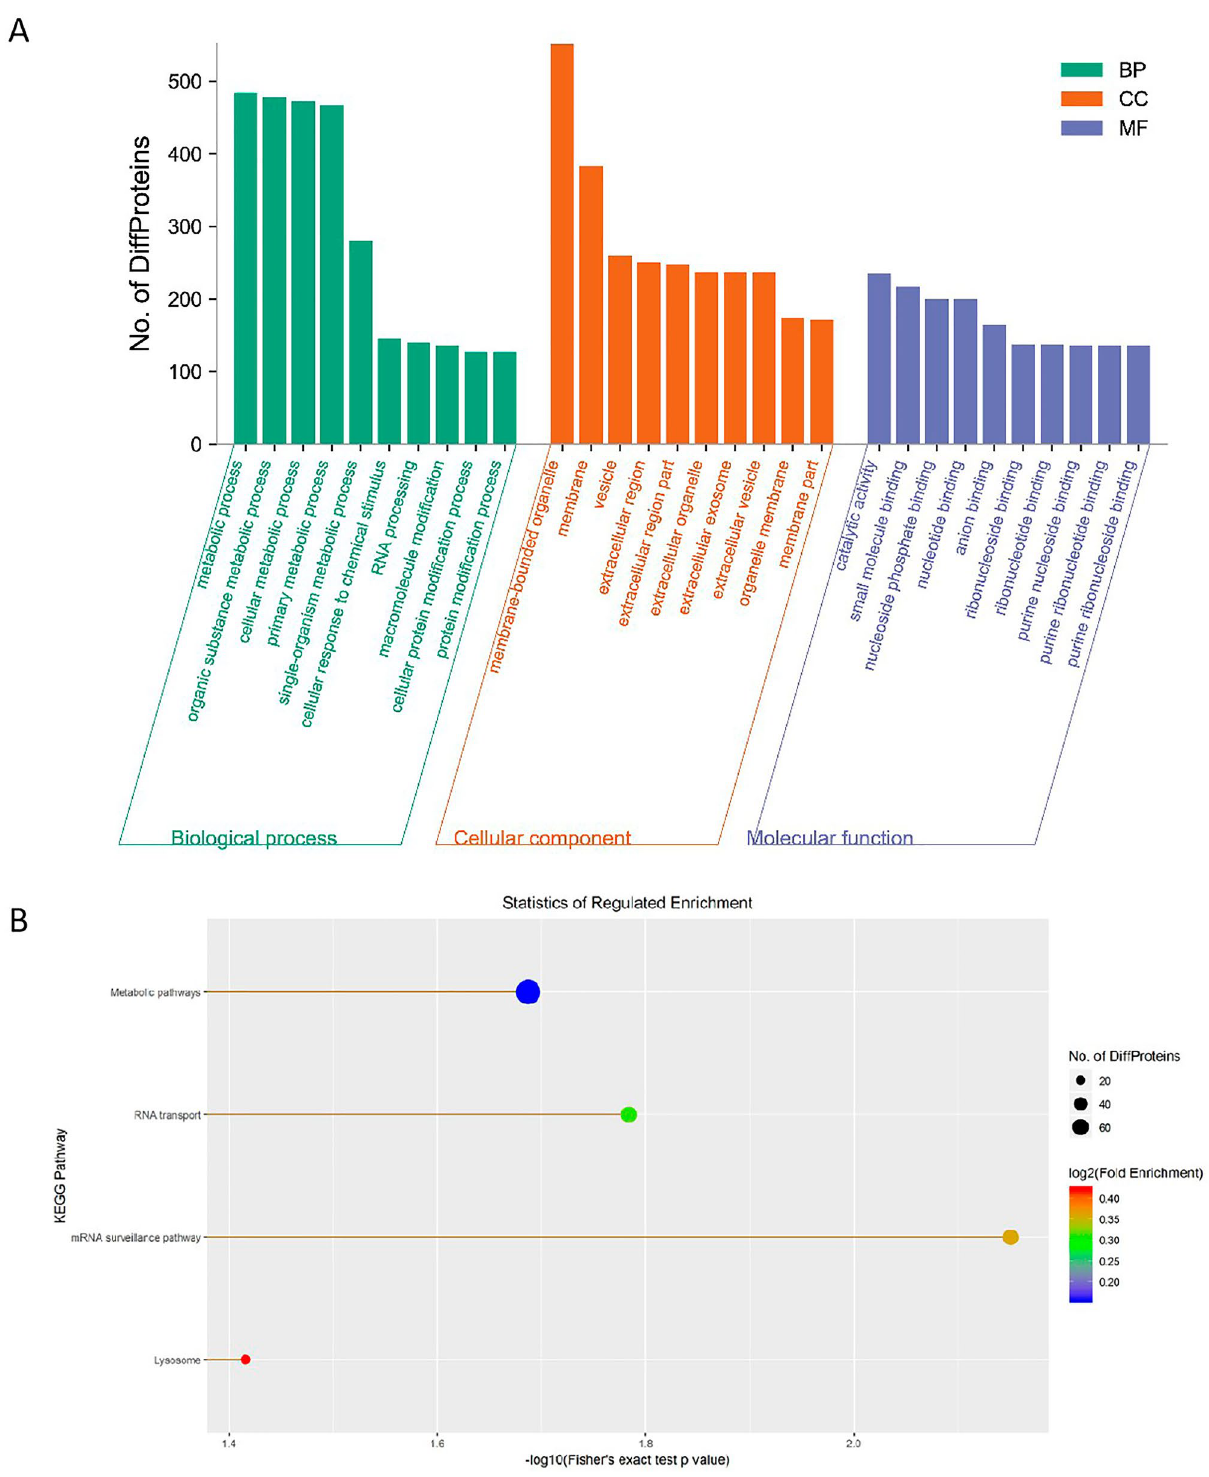
Figure 5. Functional enrichment analysis of the binding proteins of LINC00839. ( A ) Bar plot of GO enrichment in biological process (BP), cellular component (CC) and molecular function (MF) terms. ( B ) Bar plot of KEGG pathway enrichment